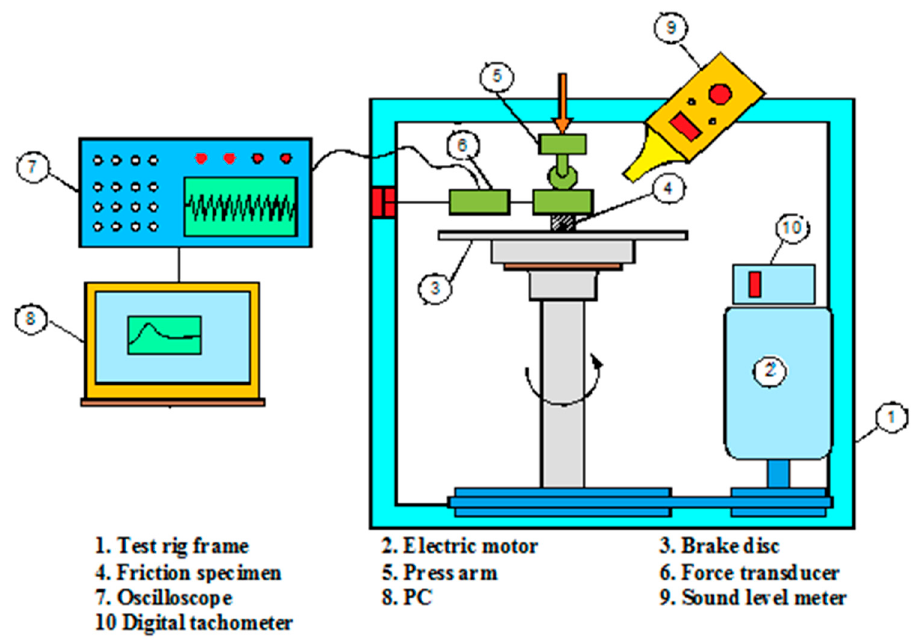
Figure 2. The schematic diagram for the pin on the disk tribological system [25].